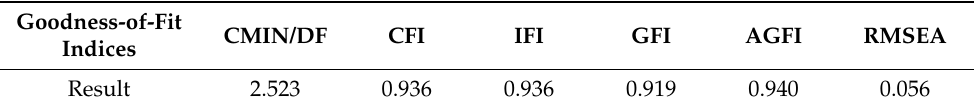
Table 7. The model fitting goodness index table with the perceived relationship bullying as the dependent variable.